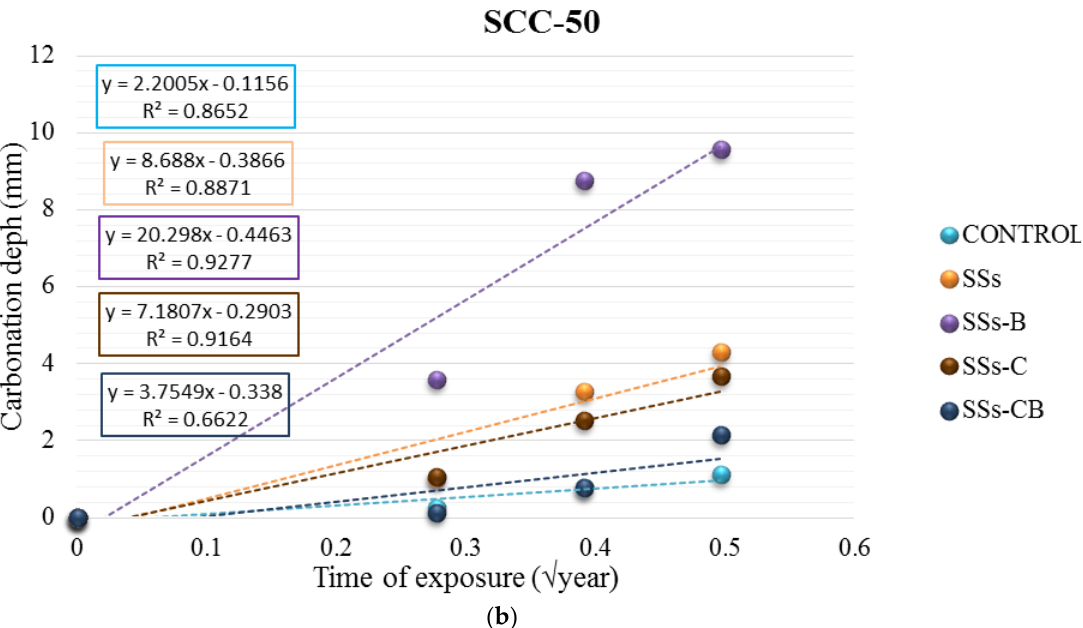
√ t of SCC-30 ( a ) and SCC-50 ( b Figure 12. Depth of carbonation according to Figure 12. Depth of carbonation according to √ 𝑡 of SCC-30 ( a ) and SCC-50 ( b ). The highest carbonation coefficient was produced in SCC-30 with the use of raw SSs (60.435 mm/√year). In the SCC-50 series, the highest values were obtained in the mixtures in which SSs-B were applied (20.298 mm/√year).